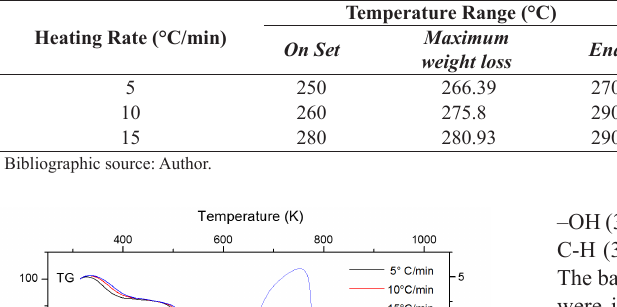
Table 4. Determination of variables to calculate the E